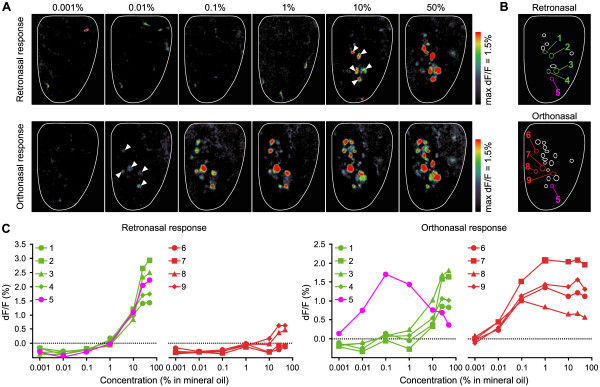
Comparison of dose–response relationships for retronasal and orthonasal airflow. A: Odor maps from a single mouse, elicited with increasing concentrations of valeric acid (0.001% – 50% v/v). Retronasal stimuli were presented for 30 s at 300 ml/min (upper panels). Orthonasal stimuli were delivered for 10 s at 150 ml/min (lower panels). White arrow heads indicate glomeruli that exhibited responses at near-threshold concentrations for each airflow pathway. Scale bar = 200 μm. B: Spatial arrangement of activated glomeruli. Open circles show the positions of glomeruli whose responses were increased by 0.5% from resting fluorescence. Among open circles, numbered and colored circles indicate the numbered glomeruli that exhibited either or both retronasal and orthonasal responses at near-threshold concentrations in panel A (retronasal: green, #1 – #4; both: magenta, #5; orthonasal: red, #6 – #9). C: The dose–response relationship to retronasal (left) and orthonasal (right) odor. The response amplitudes were analyzed for glomeruli #1 – #9 that correspond to the number in panel B. Each value is the mean of 3 trials. Note: the apparent hotspot in upper right quadrant of 0.001% v/v retronasal map was a spurious signal from a blood vessel.